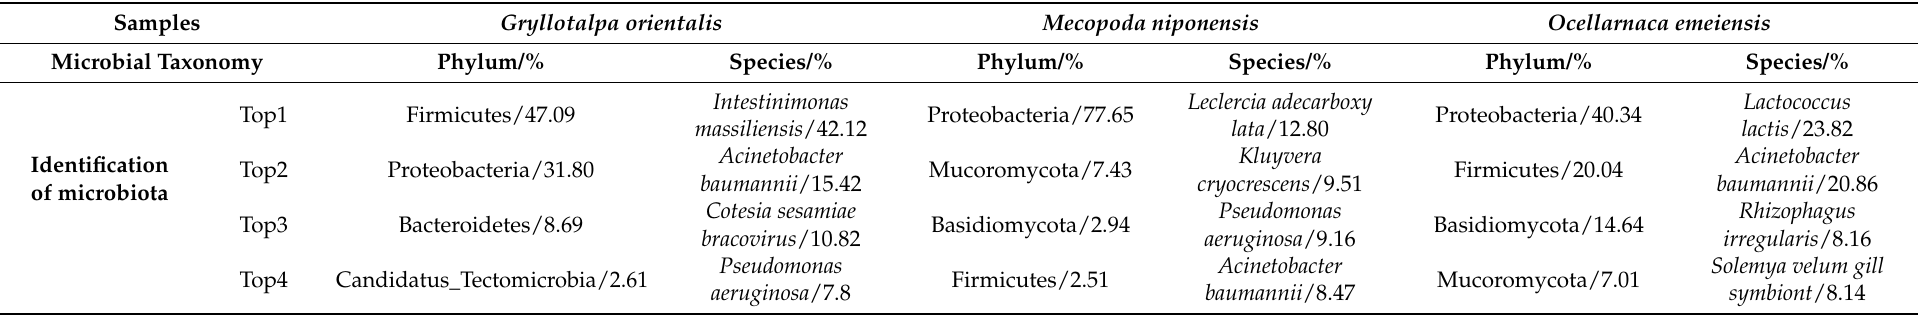
Table 2. Top 4 abundances in the gut microbiota at the phylum and species levels of samples with different feeding